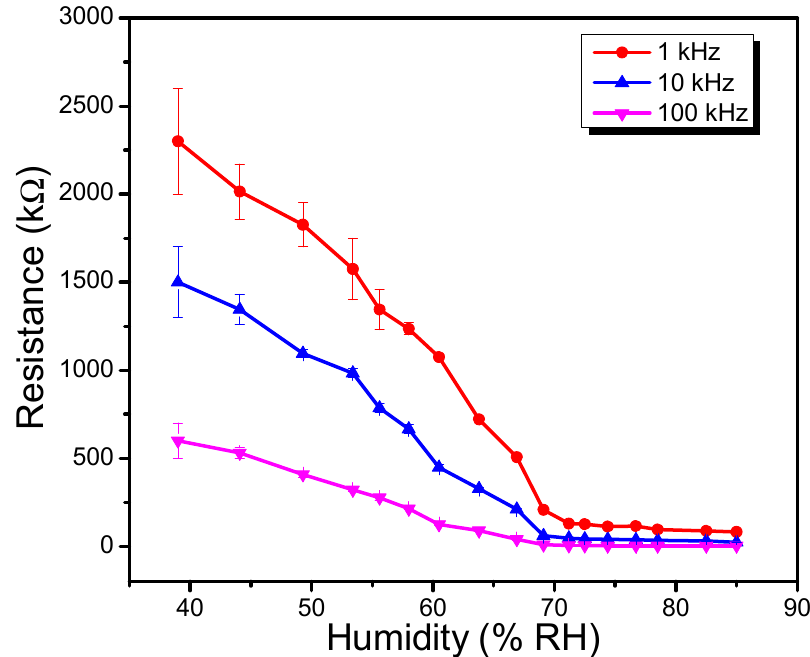
Figure 9. Effect of test frequencies on impedance vs. %RH characteristics of Al/TPPNi/Al humidity sensor.